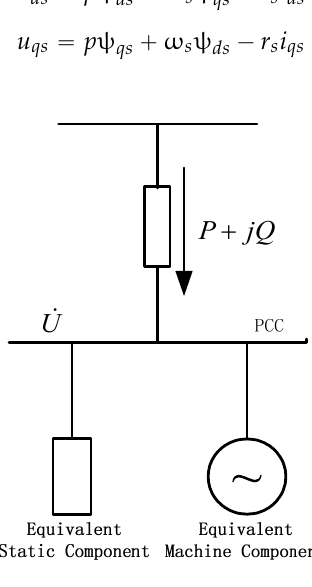
Figure 1. The equivalent model of microgrid.